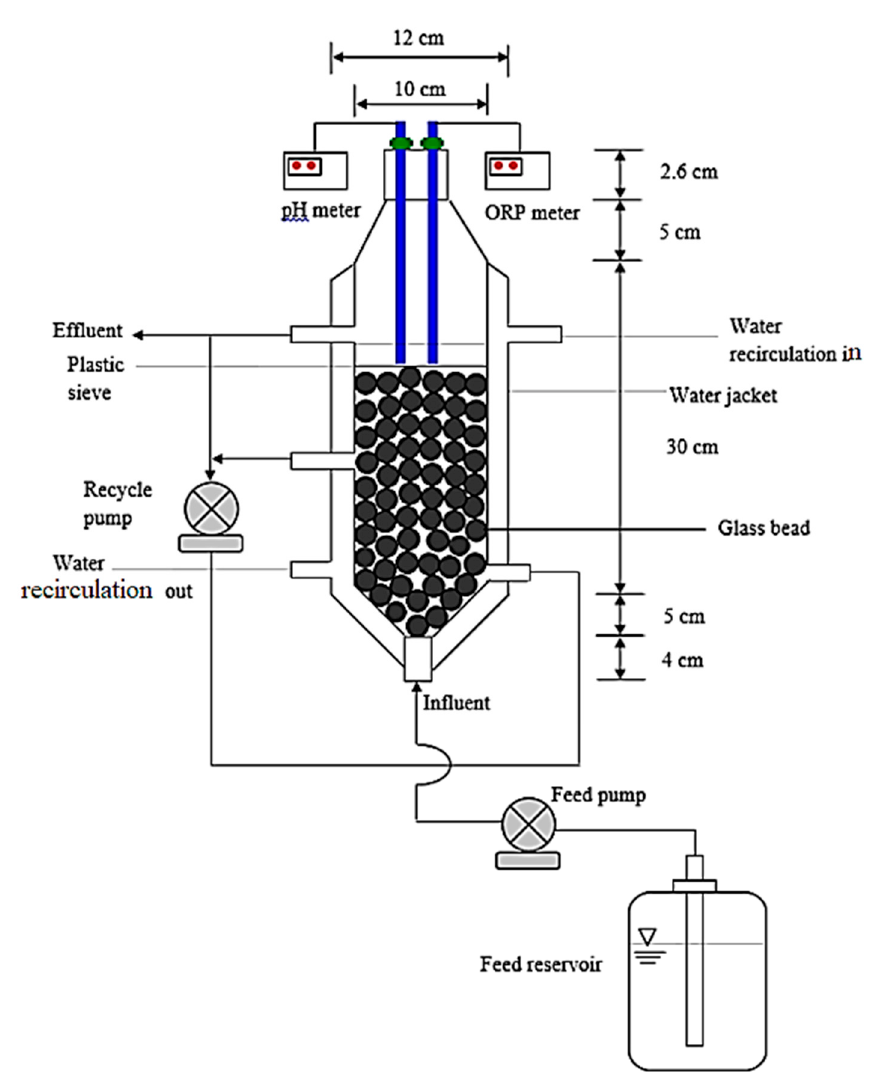
Figure 2. Schematic view of the fixed-biofilm process.